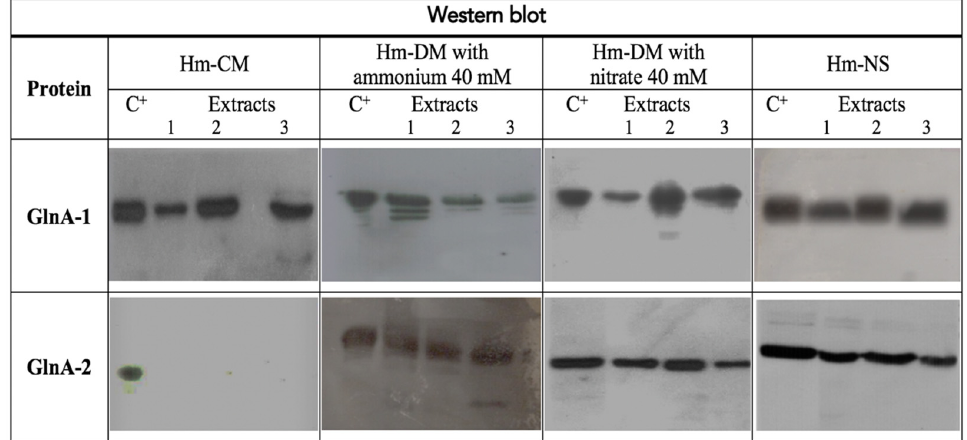
Figure 4. Hfx. mediterranei GlnA proteins expression depending on nitrogen source analyzed by Western blotting. The positive control (C + ) corresponds to the recombinant protein of GlnA-1 and GlnA-2 proteins. Line 1: initial exponential phase. Line 2: mid-exponential phase. Line 3: stationary phase. In Hm-NS, the samples correspond to 1:48 h nitrogen starvation. 2:96 h nitrogen starvation. 3:120 h nitrogen starvation.